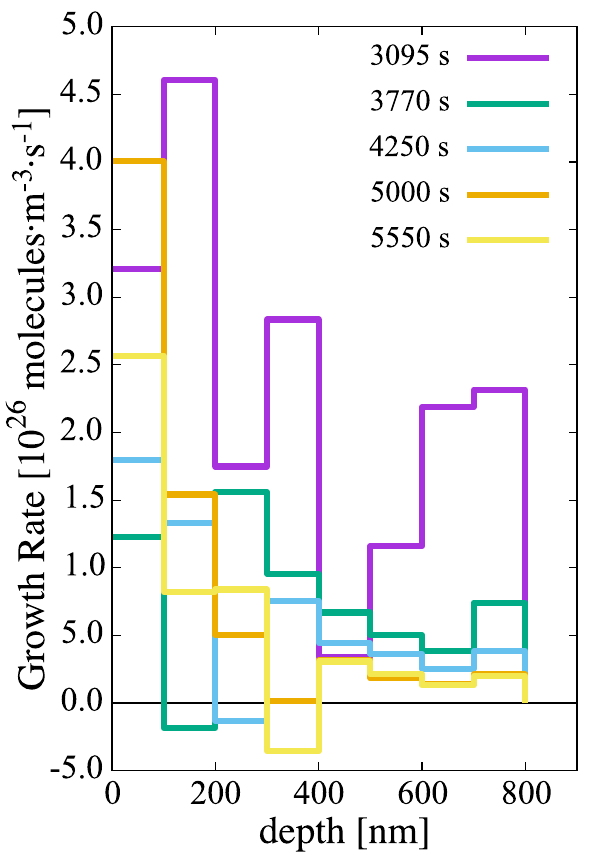
Figure 8. Growth rate of hydride clusters in the metal layer as a function of time and depth.